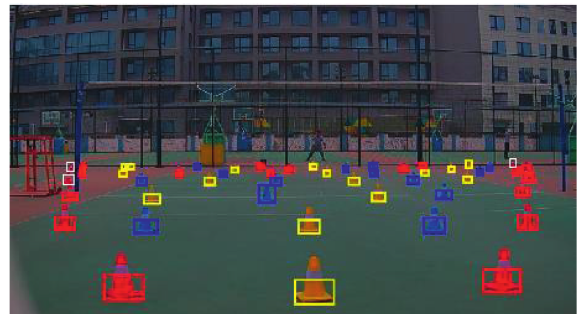
Figure 6: Traffic cone recognition static test.